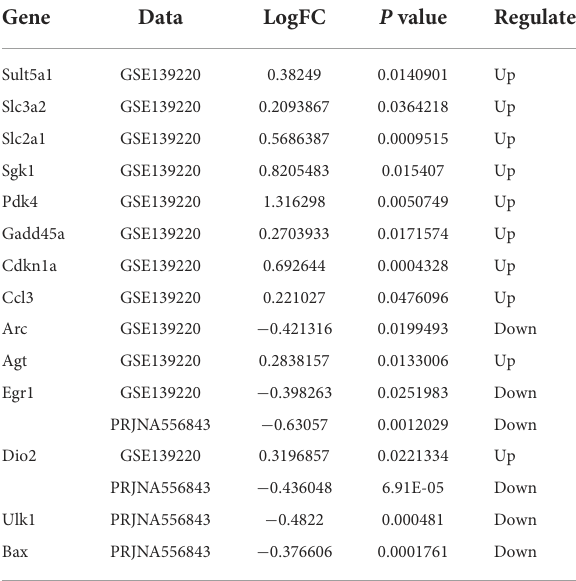
TABLE 1 Difference analysis results of 14 cross talk